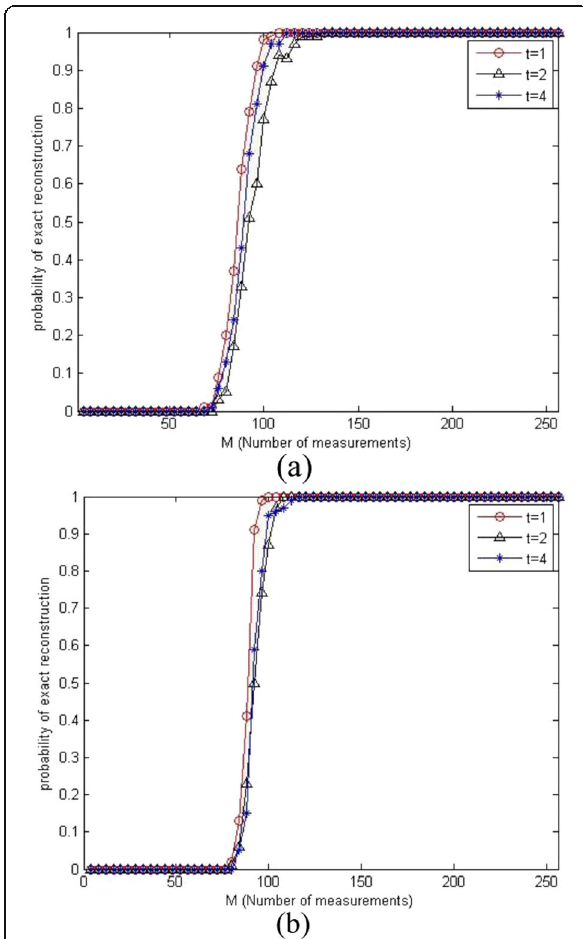
Fig. 3 Comparison of probabilities of exact reconstruction for different numbers of measurements with different dimensions of measurement matrices ( N = 256, k = 40). Frame a was obtained from l 0 -norm minimization with ρ = 0.8. Frame b was obtained from l q -norm minimization with q = 0.8 and ρ = 0.8. In frame a and b , t = 1, 2, 4 mean the dimensions of the measurement matrices are M × N , ( M /2) × ( N /2), and ( M /4) × ( N /4), respectively